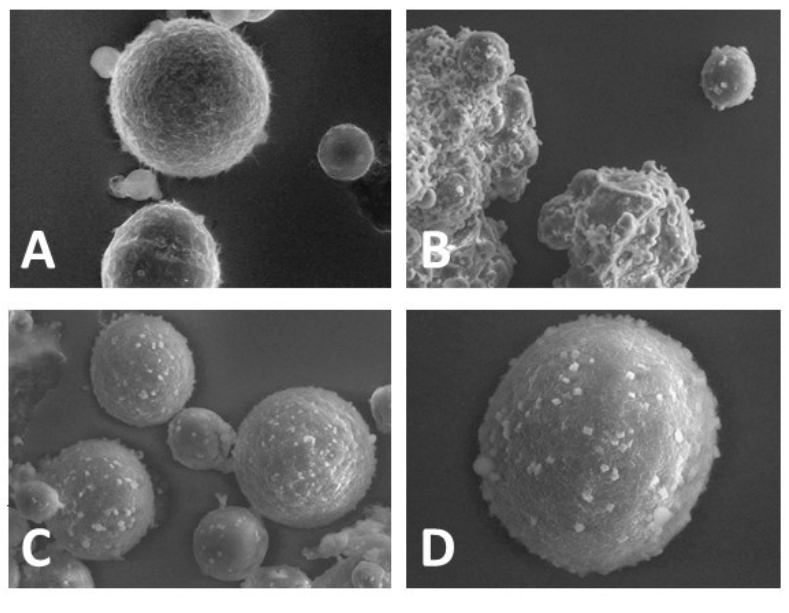
Figure 1. Variable-pressure scanning electron microscopy images (VPSEM) of LS TRIST ( A ), LS TRIST/TRIC ( B ), LS TRIST/AL30 ( C ), LS TRIST/AL15 ( D ), LS TRIST/AL10 ( E ), and LS TRIST/AL1 ( F ). Bar represents 20 μ m in panels